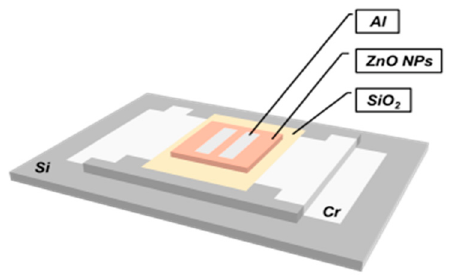
Figure 3. Description of the sensor structure.